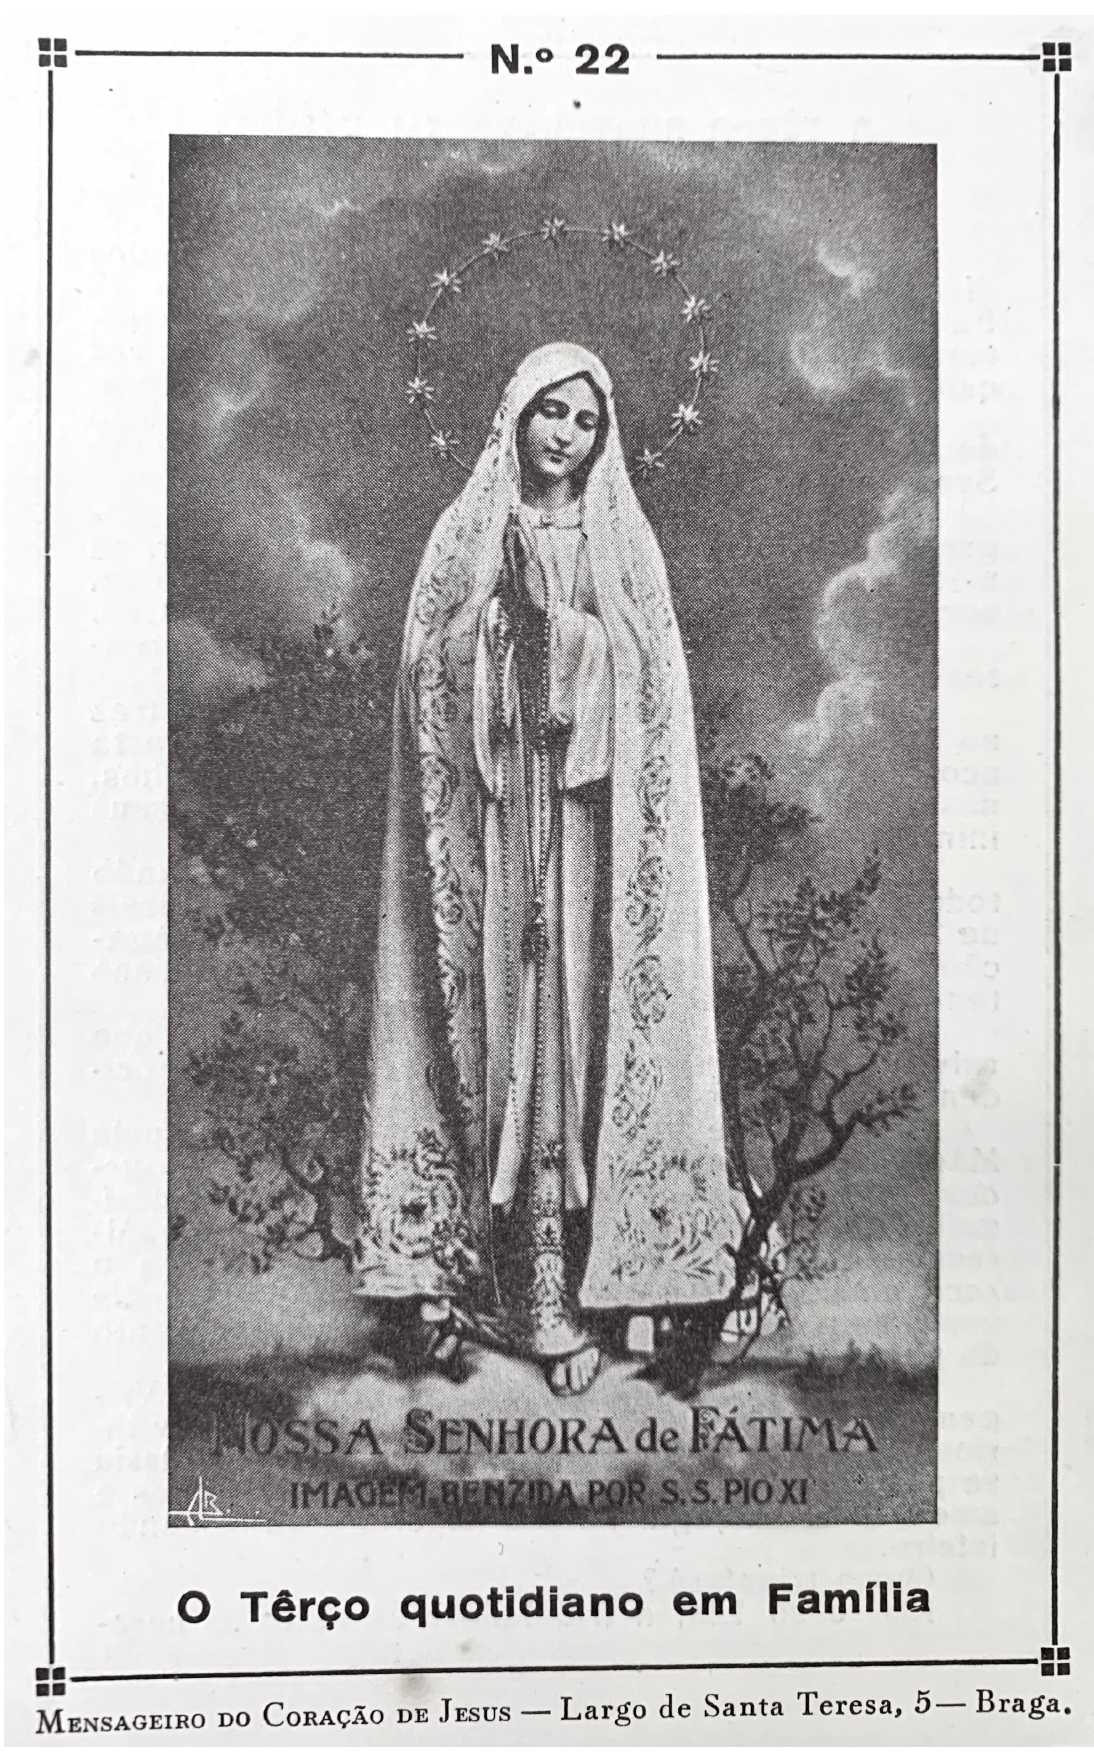
Figure 1 José Ferreira Thedim, sculptor, Our Lady of Fátima , 1920, on the cover of a tract promoting the daily rosary in the family, published July 3, 1937, in Braga, Portugal. Collection of the